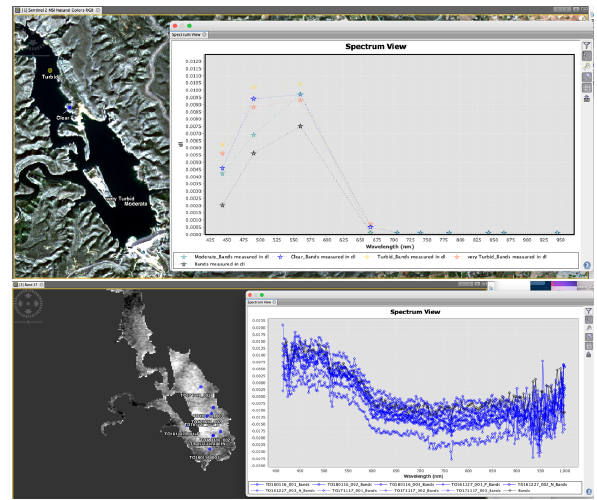
Figure 4. S2-MSI (top) ans DESIS (bottom) spectral signatures, Tous reservoir